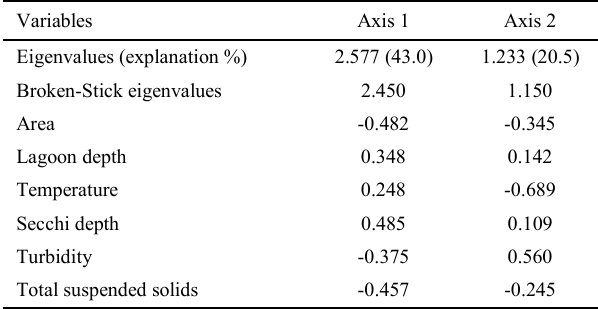
Table 3. Results of principal components analysis (PCA) ap- plied for physical